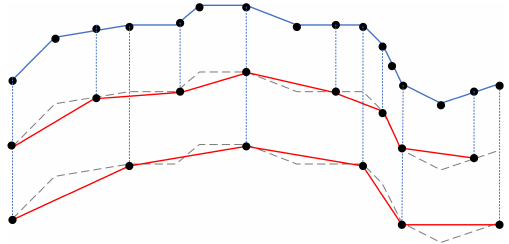
Figure 15. Resampling with intervals of two and three.